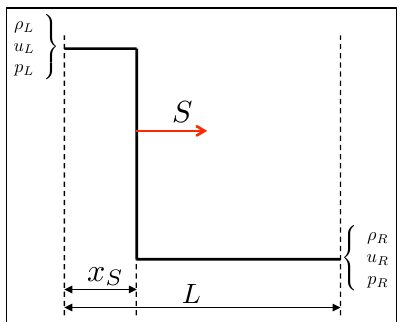
Figure 2. Schematic diagram of the one-dimensional shock tube problem. Different calculations are conducted for a series of uniformly spaced, non-adaptive computational meshes consisting of a number of grid points N between 2 9 and 2 13 . Pressure seepage and amplitude error are significantly reduced when compared to the